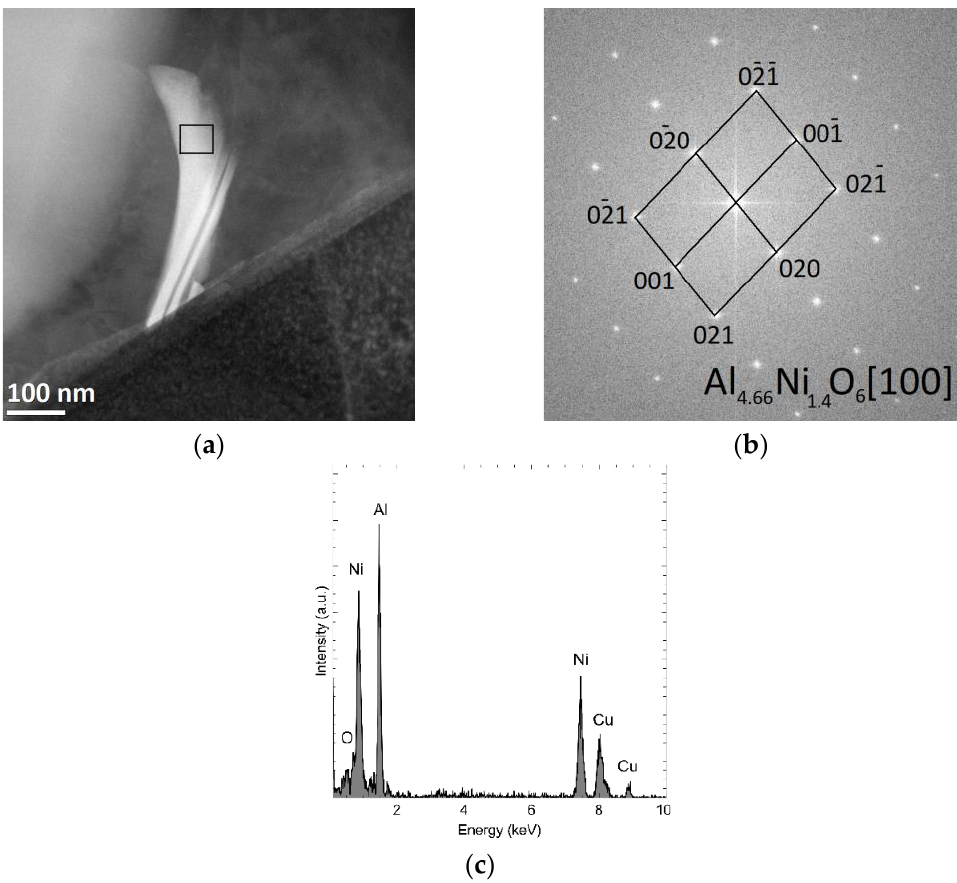
Figure 14. STEM-HAADF image of Al4.66Ni1.4O6 precipitation ( a ), Fourier transform FFT calculated for the HR TEM image taken of the marked area ( b ), and results of the chemical composition analysis obtained using X-ray dispersion spectroscopy ( c ).